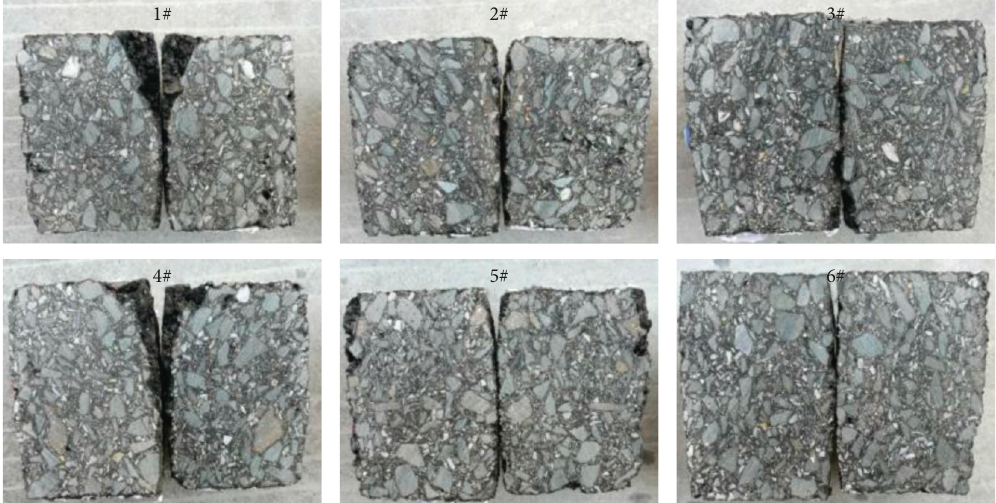
Figure 4: Cross-sectional photograph of six Marshall standard specimens. Table 4: Stability and flow value of Marshall